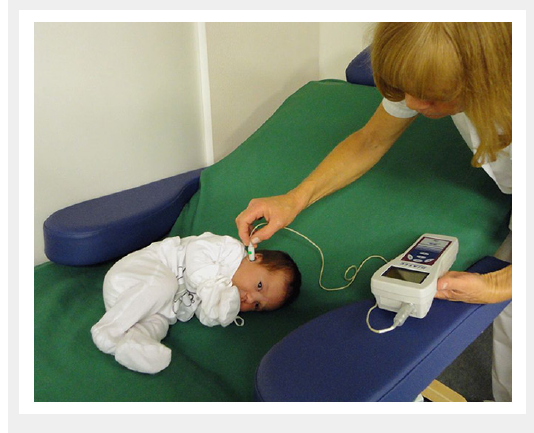
Newborn hearing screening with measurement of automated